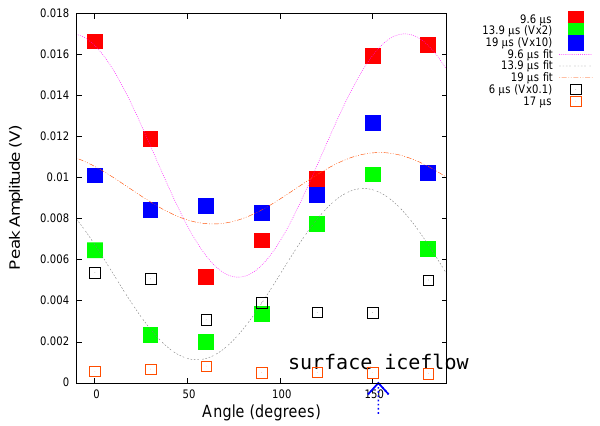
Fig. 13. Ratio of amplitudes for “fast” vs. “slow” reflection signals, as a function of azimuthal orientation of co-polarized surface horns. Blue arrow indicates azimuth corresponding to local horizontal ice flow